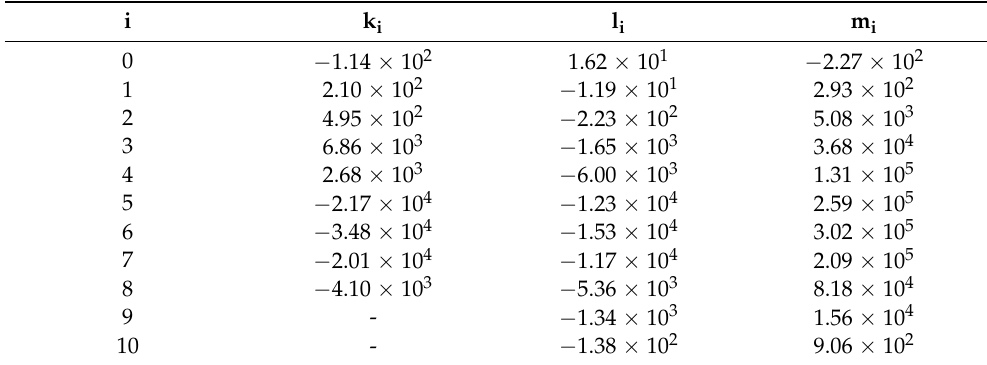
Table A33. Coefficients of the H 2 O-NaOH saturated pressure